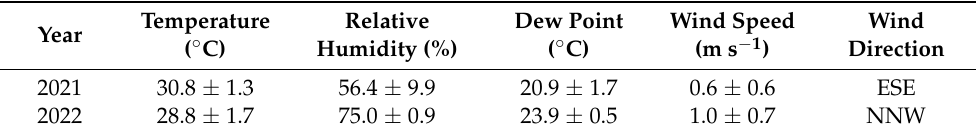
Table 2. Meteorological conditions recorded during spray testing in 2021 and 2022. Values are averaged across the applications for each year and represent mean ± standard